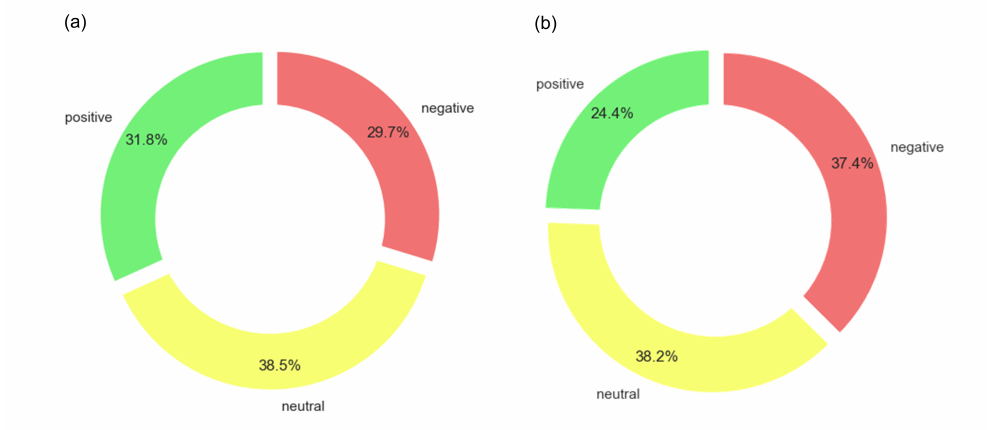
Figure 2. Distribution of sentiment classes (n = 97,662). ( a ) before Twitter acquisition (n = 30,128), ( b ) after Twitter acquisition (n =